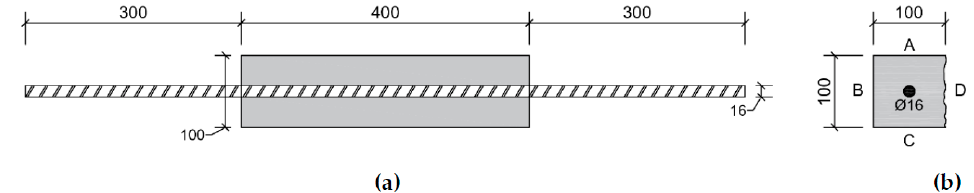
Figure 4. ( a ) Side view of reinforcement in prismatic specimen used to evaluate visual crack healing; ( b ) Cross-section of prismatic specimen used to evaluate visual crack healing (A: top surface, B: side surface, C: bottom surface, and D trowelled surface) (dimensions in mm). Materials 2020 , 13 , x FOR PEER REVIEW